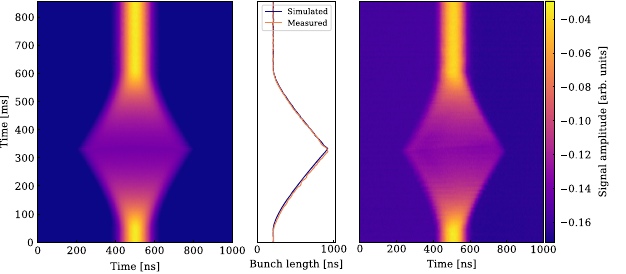
FIG. 5. Evolution of the bunch profile during slow expansion and compression at a normalized speed of smooth transitions indicate an adiabatic manipulation. Simulated (left) and measured (right) profiles are shown with their corre- sponding bunch lengths.